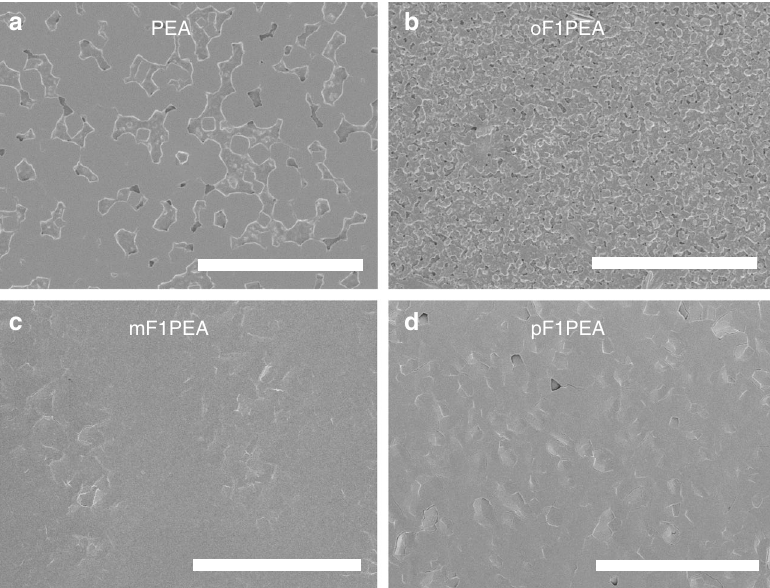
Fig. 3 Surface morphology of 2D OIHP fi lms: SEM images of 2D OIHP fi lms based on a PEA, b oF1PEA, c mF1PEA, and d pF1PEA. Scale bar is 10 µ